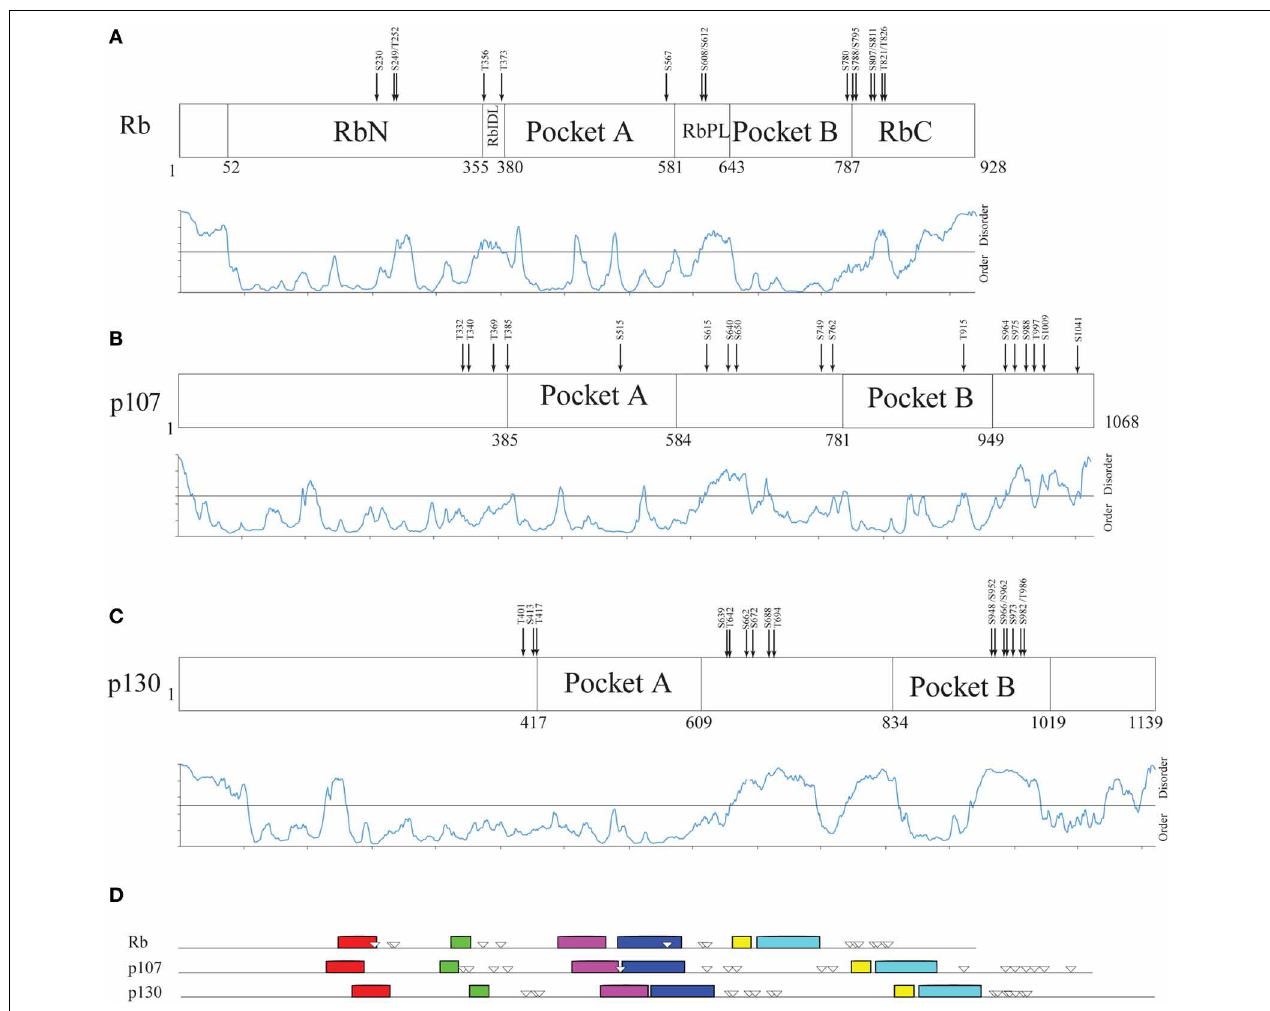
FIGURE 5 | Structural organization of human Rb-like proteins. (A–C) PONDR-FIT disorder prediction combined with functional domain organization for paralogs Rb (A) , p107 (B) , and p130 (C) . (D) The pattern of